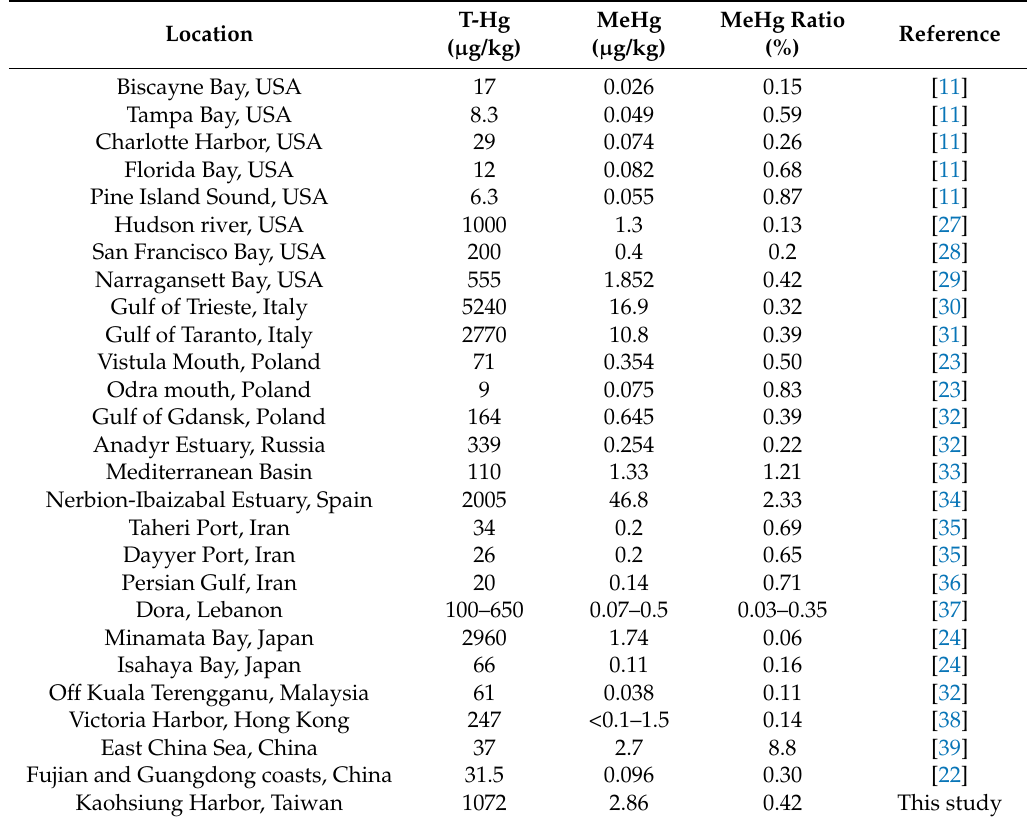
Table 4. Total mercury (T-Hg), methylmercury (MeHg), and the ratio of MeHg to T-Hg (MeHg ratio) in the sediments of the different regions of the